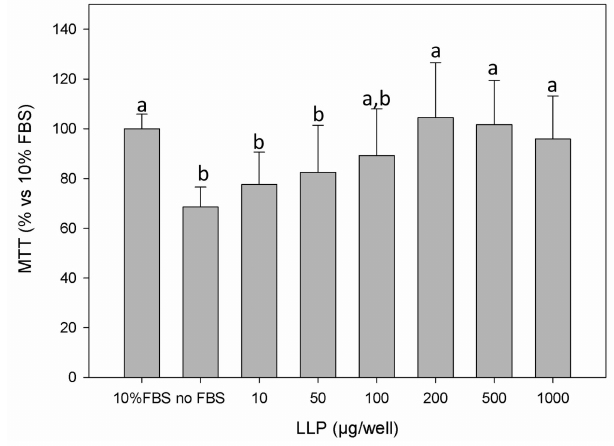
Figure 2. MTT assay on HepG2 after LLP treatment (48 h) in serum-free medium. LLP treatments ranging from 200 µ g to 1000 µ g/well increased the MTT signal with respect to serum-free control cul- tures ( p < 0.001). A dose-dependent trend was observed; higher concentrations of LLP demonstrated an effect comparable to 10% FBS supplementation. Absence of a common letter means a statistically significant difference ( p < 0.001).